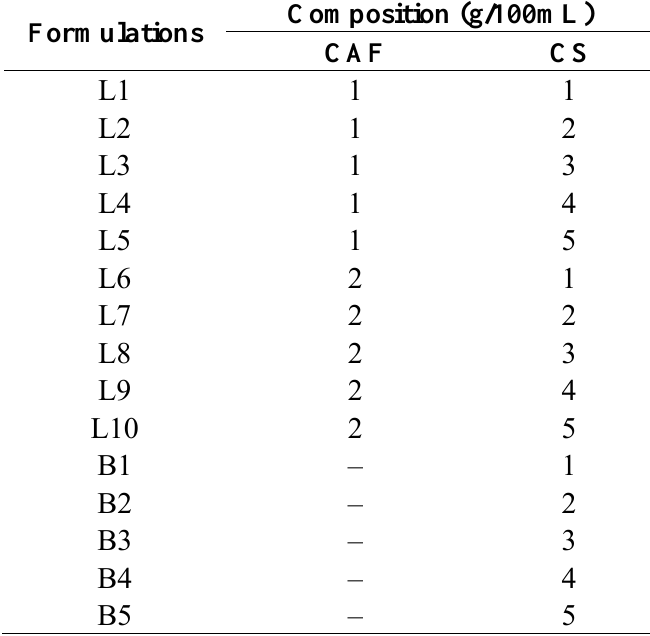
Table 1. Proportions of caffeine and chitosan in solutions used in the preparation of lyophilized